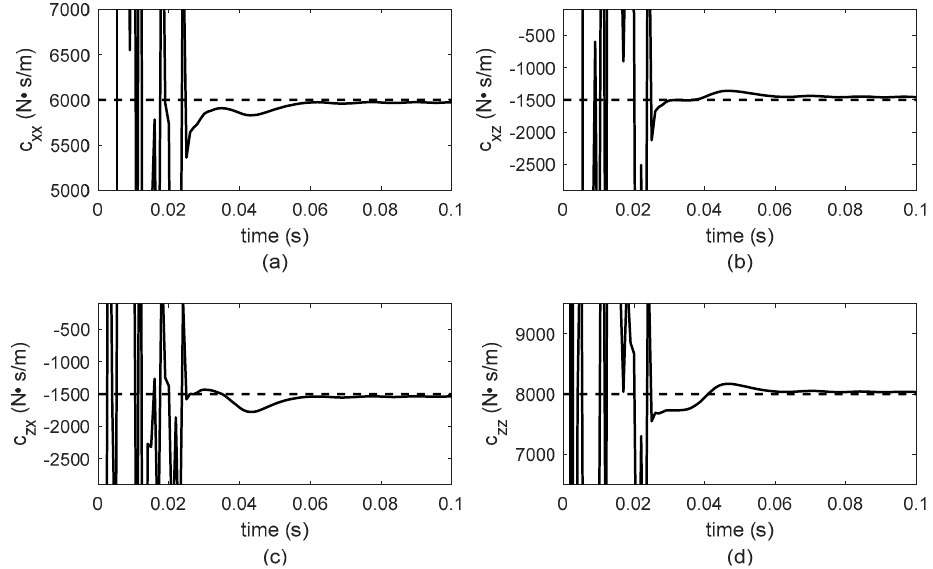
Figure 19. Identified damping parameters for bearing 2 with a ramp excitation of 6000 (cid:1870)(cid:1853)(cid:1856)/(cid:1871) (cid:2870) . ( a ) (cid:1855) (cid:3051)(cid:3051) , ( b ) (cid:1855) (cid:3051)(cid:3053) , ( c ) (cid:1855) (cid:3053)(cid:3051) , ( d ) (cid:1855) (cid:3053)(cid:3053) .